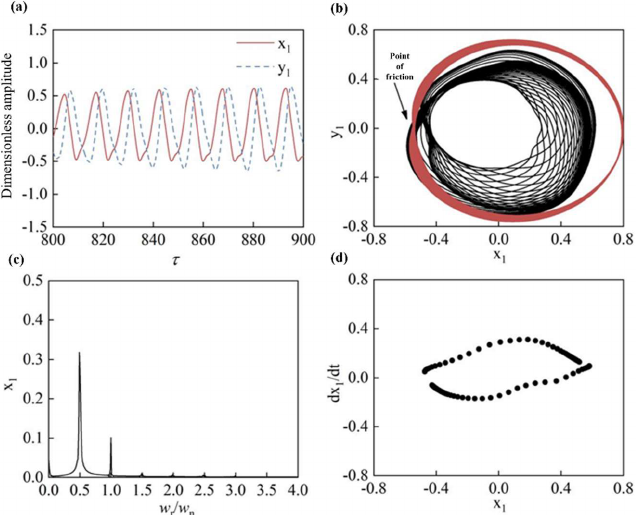
Figure 8. Rotor dynamic response under rub-impact: ( a ) time domain curve of impeller displacement change; ( b ) impeller axis locus; ( c ) frequency spectrum of impeller; ( d ) impeller poincare drawing.